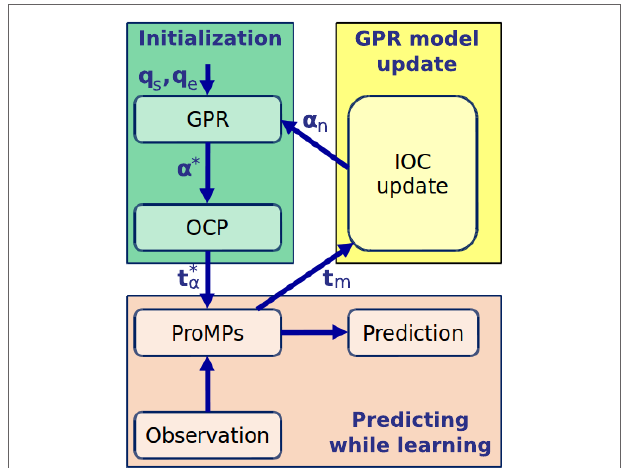
FIGURE 4 | Overview of the prediction framework (upper right in Figure 1 ). q s and q e are the initial and final joint angle configurations. α * is the estimated optimal weight vector and t ∗ (cid:11) is the corresponding optimal solution from OCP. t m denotes the mean of the converged trajectory distribution extracted from the ProMPs, α n is the new obtained optimal weight vector, which is used to update the GPR